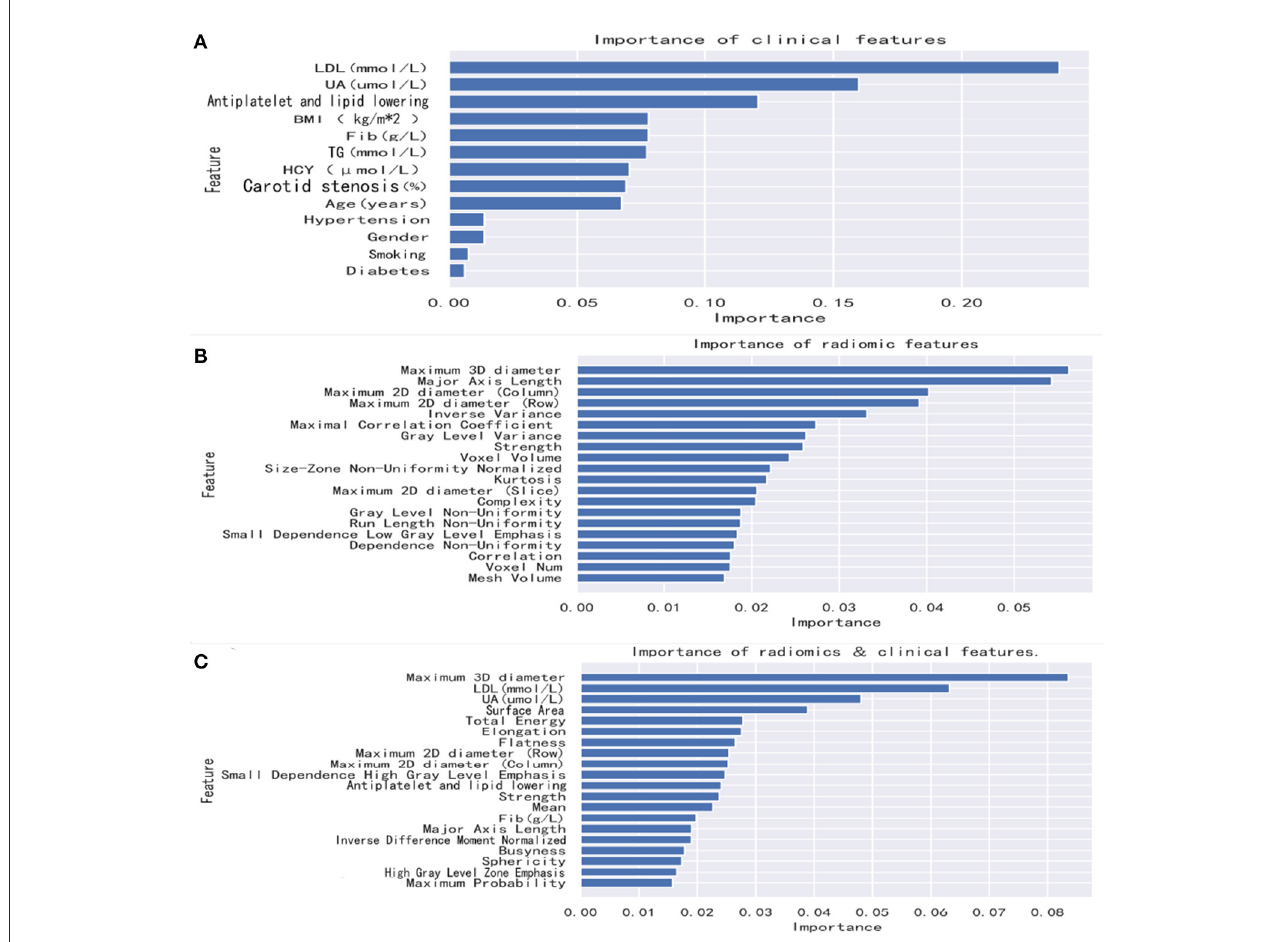
FIGURE3 Feature importance in the random forest model. Radiomics features and combined features show only the top 20 features. Clinical features show all features. (A) The random forest method was used to rank clinical features from high to low importance. (B) The random forest method was used to rank radiomics features from high to low importance. (C) The random forest method was used to rank combined features from high to low importance. BMI, body mass index; UA, uric acid; TG, triglycerides; LDL, low-density lipoprotein; Fib, fibrinogen; HCY,